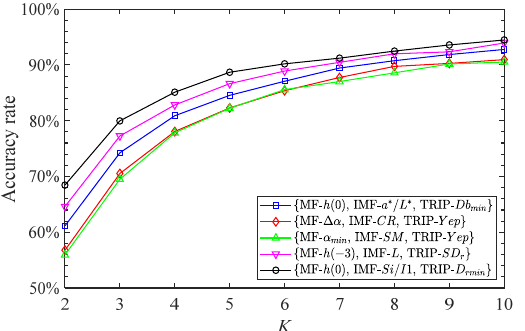
Figure 6. The average AR between two varieties under different feature combinations.